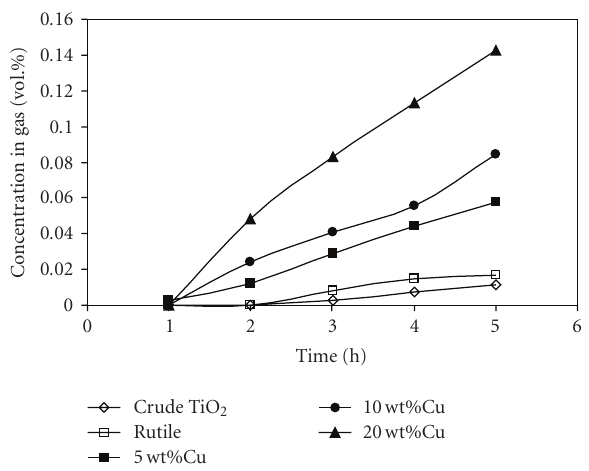
Figure 5: Photocatalytic generation of hydrogen on di ff erent